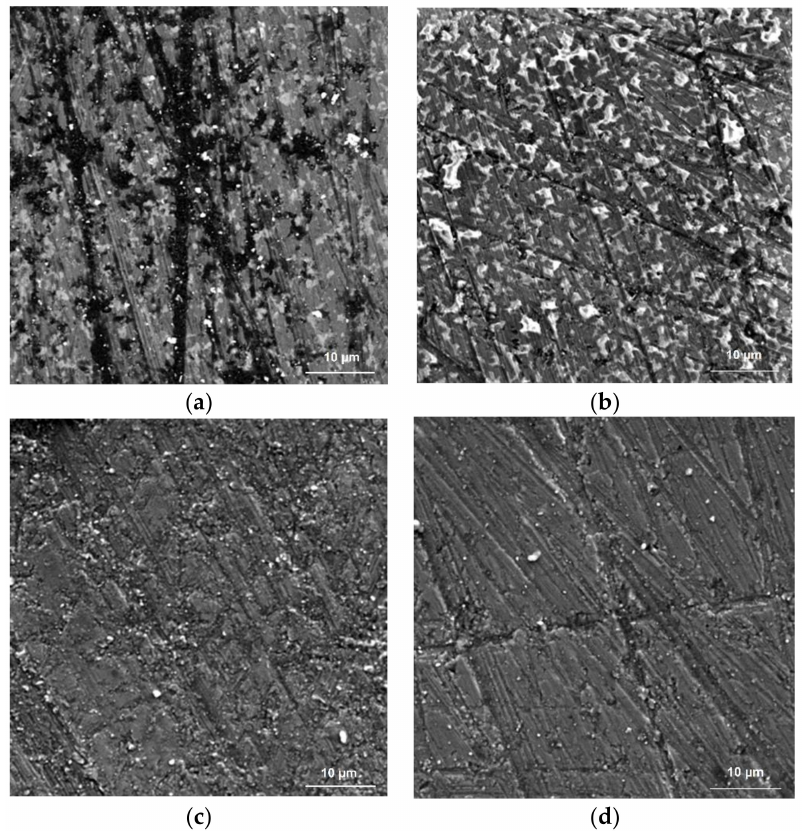
Figure 7. The SEM images ( × 5000) of the front surface of the samples before coating and after depositing the diamond-like coating: ( a ) The Al 2 O 3 + TiC ceramic sample before coating; ( b ) The Al 2 O 3 + SiC ceramic sample before coating; ( c ) The Al 2 O 3 + TiC ceramic sample after depositing the diamond-like coating; ( d ) The Al 2 O 3 + SiC ceramic sample after depositing the diamond-like